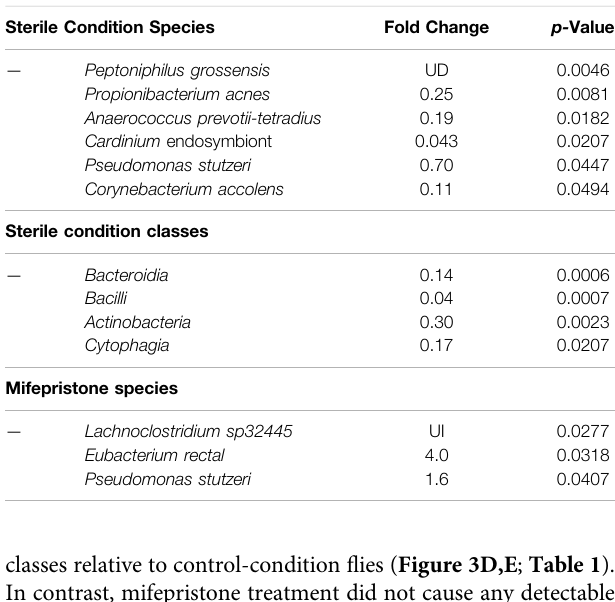
TABLE 1 | Bacterial species changes due to egg sterilization and mifepristone. UD, unde fi ned decrease (treatment value equal to zero); UI, unde fi ned increase (control value equal to zero). Statistical test: Mann – Whitney nonparametrictest.Formifepristonespecies Pseudomonasstutzeri, the p- valueis presented for unpaired, two-sided t